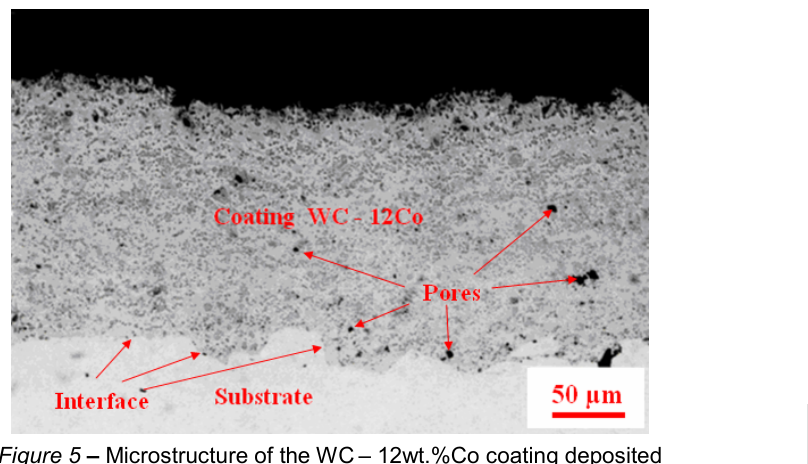
Figure 5 – Microstructure of the WC – 12wt.%Co coating deposited with a helium feed rate of 16